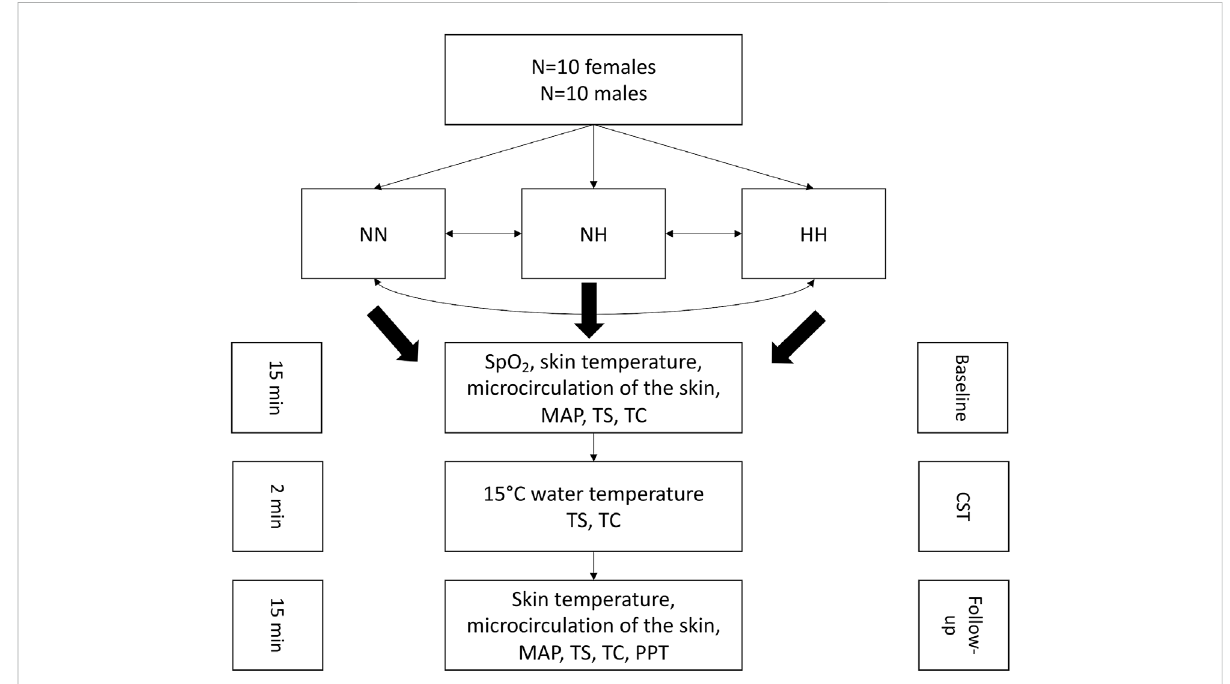
FIGURE 1 Schematic representation of the experimental protocol. NN: normobaric normoxia, NH: normobaric hypoxia, HH: hypobaric hypoxia, MAP: mean arterial pressure, TS: thermal sensation, TC: thermal comfort, CST: cold-stress test, PPT: pressure pain